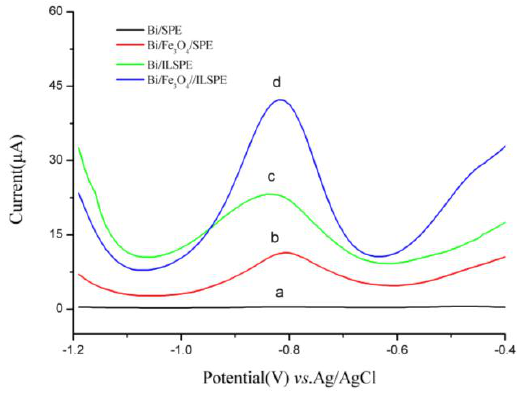
Figure 6. DPV responses of 40 µg/L Cd(II) and 400 µg/L Bi(III) in 0.2 mol/L phosphate buffer solution (pH 5.0) on the ( a ) SPE, ( b ) Fe 3 O 4 /SPE, ( c ) ILSPE, and ( d ) Fe 3 O 4 /ILSPE. Deposition time: 240 s. Deposition potential: −1.2 V.